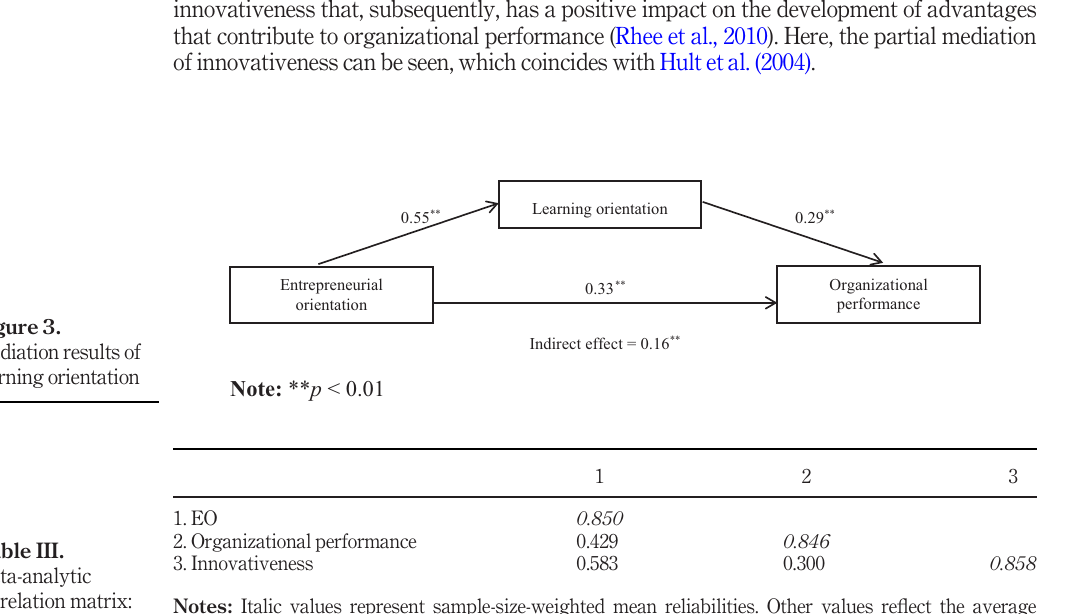
Table III. Meta-analytic correlation matrix: innovativeness